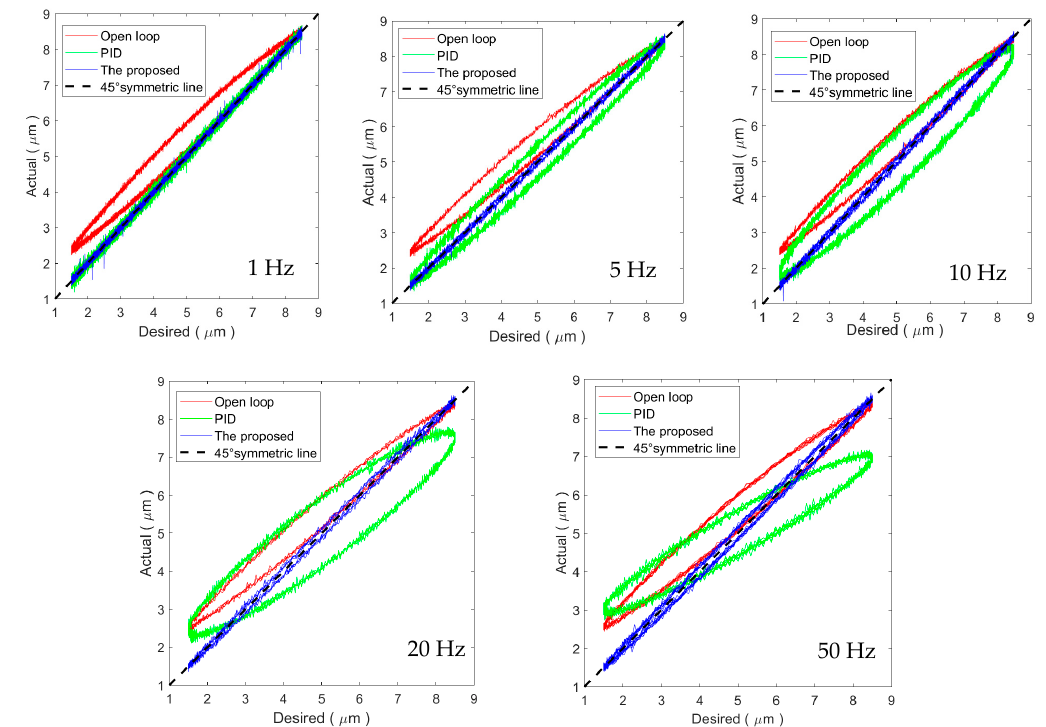
Figure 11. Hysteresis compensation e ffi ciency for the sinusoidal trajectories.